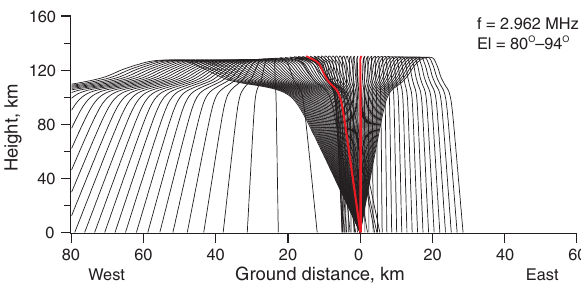
Figure 10. Ray plots for initial elevation angles from 80 to 94 ◦ with increments of 0.2 ◦ at a frequency of 2.962MHz. Red lines show ray paths that returned to the receiver (ionosonde).